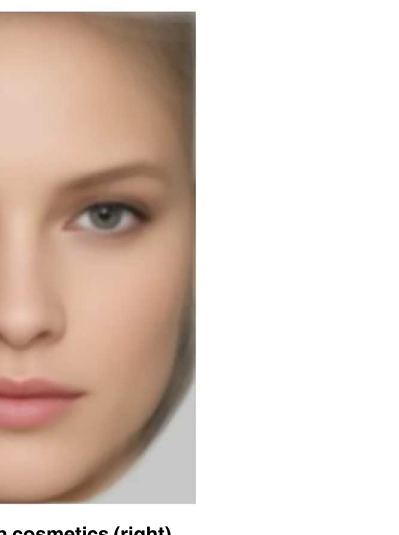
faces here, finding that the sample of supermodels ( M = 4.29, [3.95, 4.63]) were perceived as